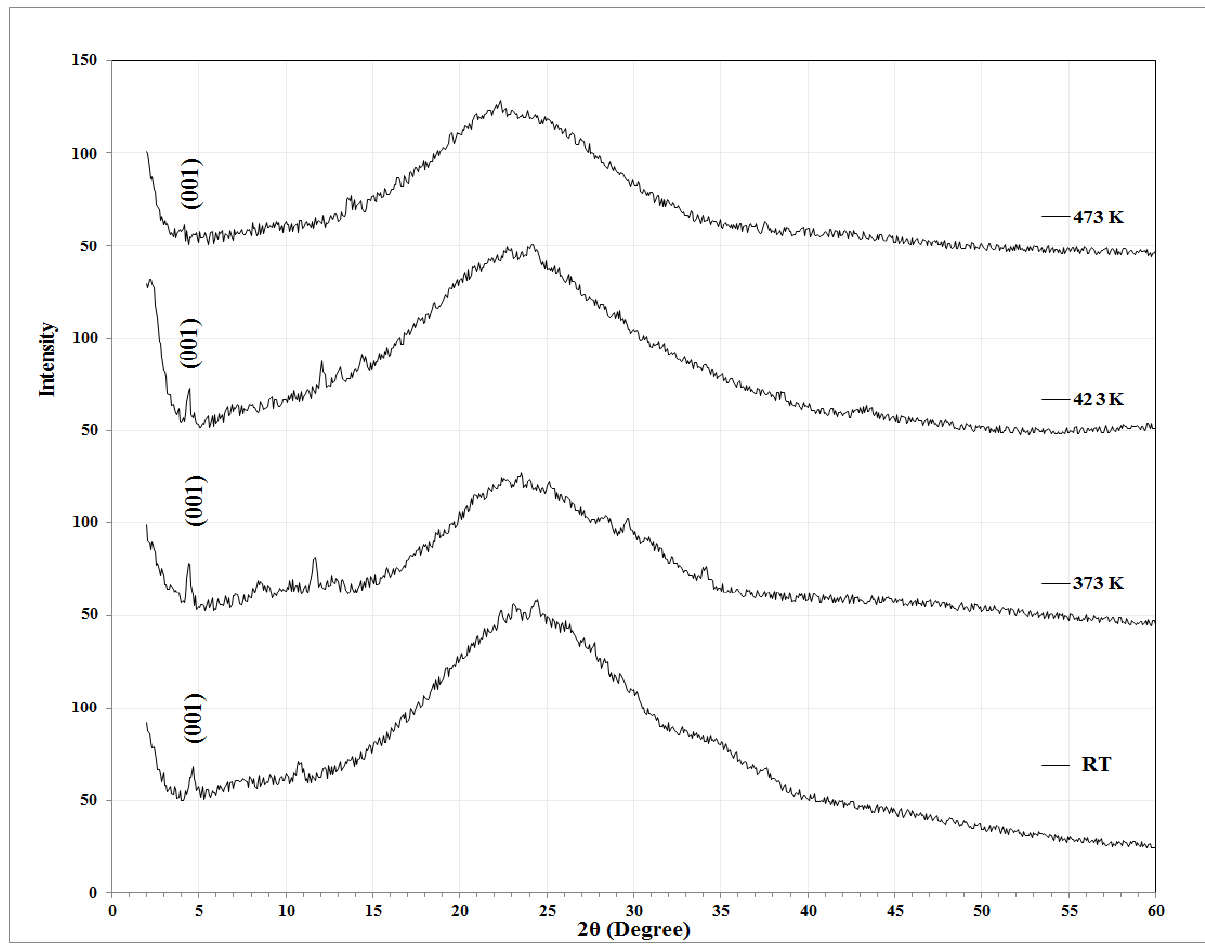
Fig. 1: XRD patterns for CuPcTs/PEDOT:PSS thin films deposited on glass substrate annealed at different temperatures.